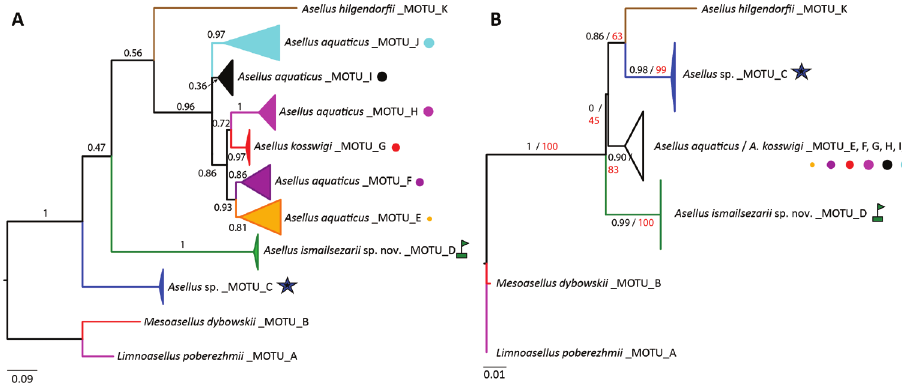
Figure 8. Phylogenetic relationships among taxa belonging to the Asellus pattern derived from Maximum likelihood analysis of ( A ) 585 COI mtDNA sequences, ( B ) thirty 28S rDNA sequences. The clade com- prised of M. dybowskii and L. poberezhnii was used as outgroup. In A, branches to molecular operational taxonomic units (MOTU) as delimited with the fixed threshold method implemented by Lefébure et al. (2006) were collapsed. In B, branches to the main clades were collapsed. Colors and symbols as in Fig. 9. Branch supports are approximate likelihood ratio test (aLRT) values (black) and bootstrap values (red).